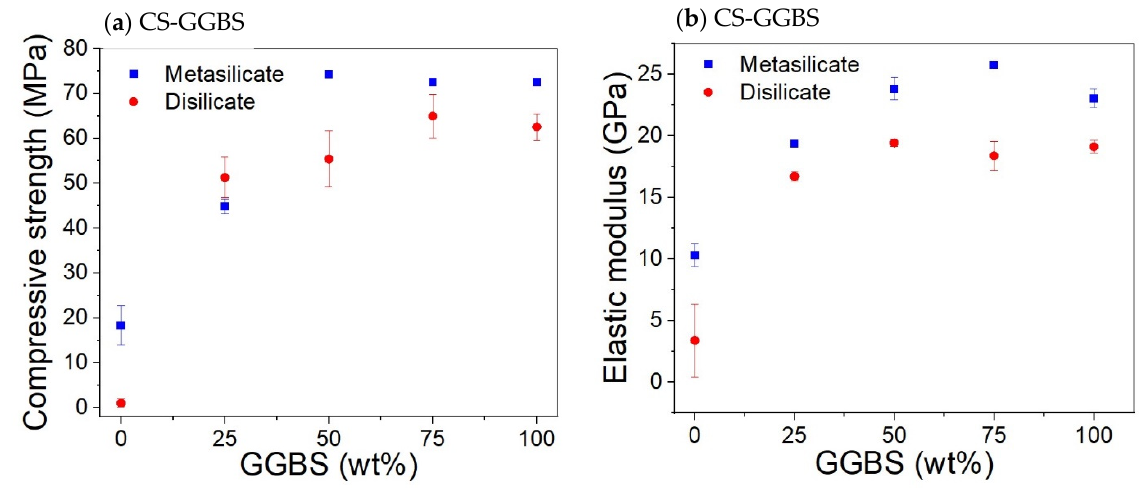
Figure 4. Effect CS substitution on the compressive strength ( a ) and elastic modulus ( b ) of CS/GGBS based system with 10 wt%. DS/MS.